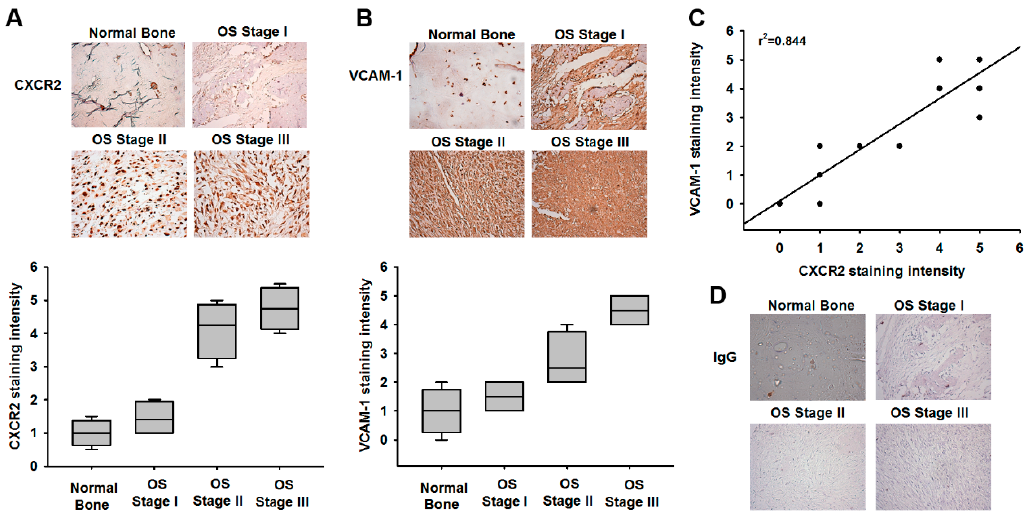
Figure 2. Osteosarcoma specimens exhibit significant correlations between CXCR2 and VCAM-1 expression, and tumor progression. ( A , B ) Tumor specimens were stained with CXCR2 and VCAM-1 antibodies, then photographed by optical microscope. The lower panels quantify the expression levels of CXCR2 and vascular cell adhesion molecule 1 (VCAM-1) in different disease stages. ( C ) Immunohistochemistry (IHC) staining scores of CXCR2 and VCAM-1 were paired from the same specimens and the correlation between CXCR2 and VCAM-1 expression levels was shown by linear regression in prostate cancer specimens. ( D ) Control IgG antibody was used as a negative control in IHC staining.